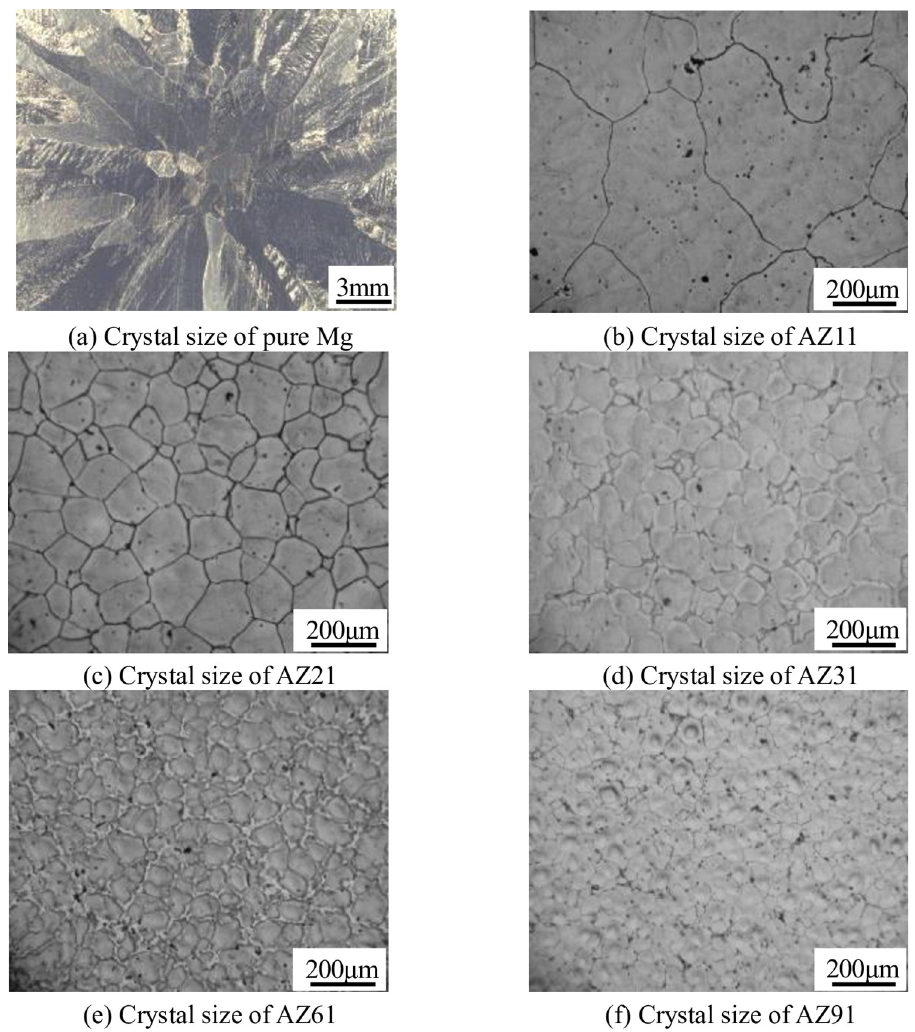
Fig 3. Metallographic analysis of Mg-Al alloys after refinement. (a) Crystal size of pure Mg; (b) Crystal size of AZ11; (c) Crystal size of AZ21; (d) Crystal size of AZ31; (e) Crystal size of AZ61; (f) Crystal size of AZ91.